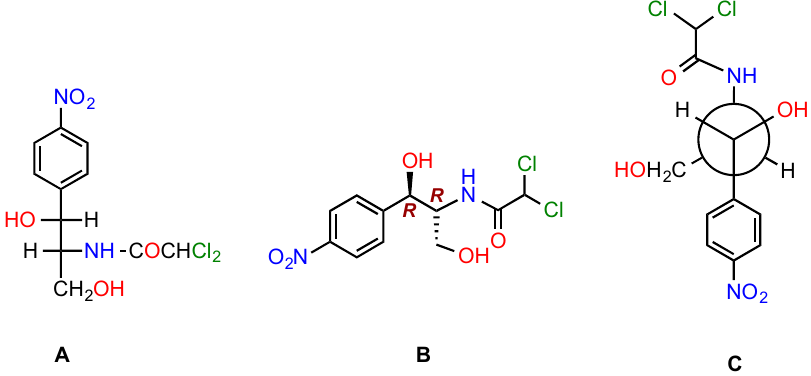
Figure 1. Alternative structures for CAM. ( A ) Fischer projection (D- threo isomer); ( B ) Skeletal formula showing the configuration of the two stereogenic centers; ( C ) Newman projection.